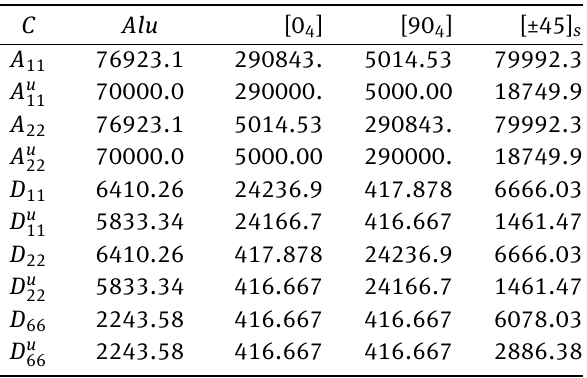
Table 2: Resistances against constrained and unconstrained defor- mation